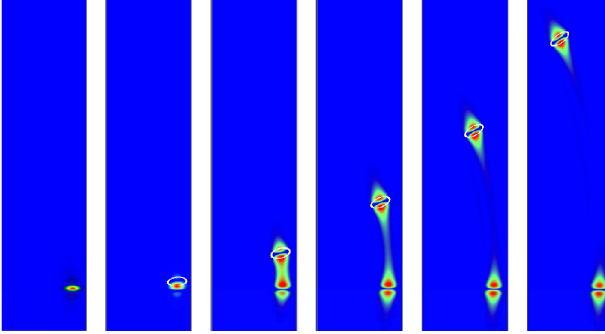
~E FIG. 8. Absolute value of the electric field dp on the horizon- tal plane in the vertical center of the vacuum chamber in consecutive time steps. The red color corresponds to maximum value. The blue color corresponds to the minimum value of the field. The white oval shows the real bunch contour.